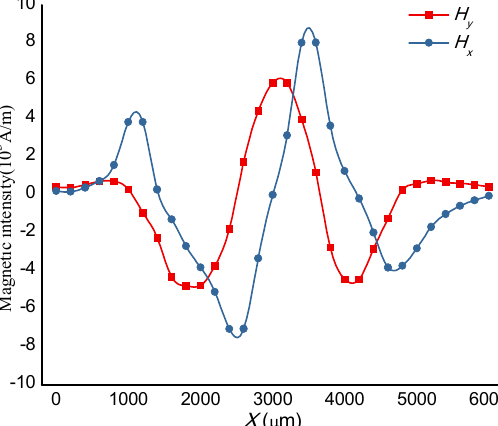
Figure 5. Velocity profile near the magnets. 4. Results and Discussions 4.1. Effect of Magnets Arrangement It can be foreseen that the magnetic pole arrangeme nt will affect the magnetic gradient and will subsequently affect the forces on microparticles and the trajectory of microparticles. Two kinds of magnetic pole arrangements named NSN and NNN are simulated for 3 μm, 4 μm and 5 μm nonmagnetic microparticles at the same conditions as mentioned above. Figure 6 indicates that the separation result for the NSN arrangement is much better than that for the NNN arrangement because a greater magnetic gradient in the y-direction can be obtained for the NSN arrangement. N S N